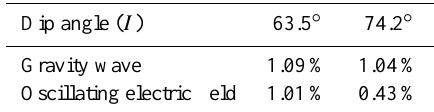
Table 1. Model calculation of amplitude in TEC